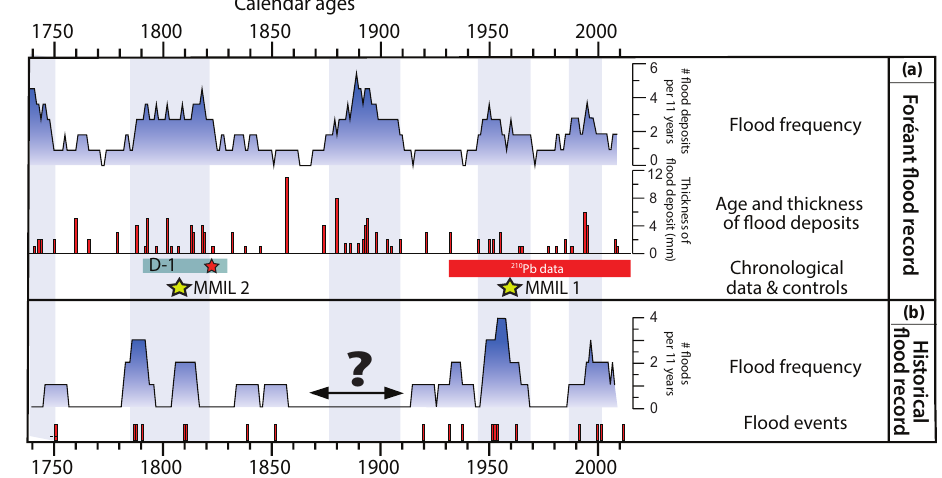
Figure 7. Comparison over the last 250years of the reconstructed Foréant flood frequency (11-yr running sum) and intensity (thickness of flood deposits) with the frequency (11-yr running sum) of historical floods at Ristolas. The question mark refers to a possible gap in the historical